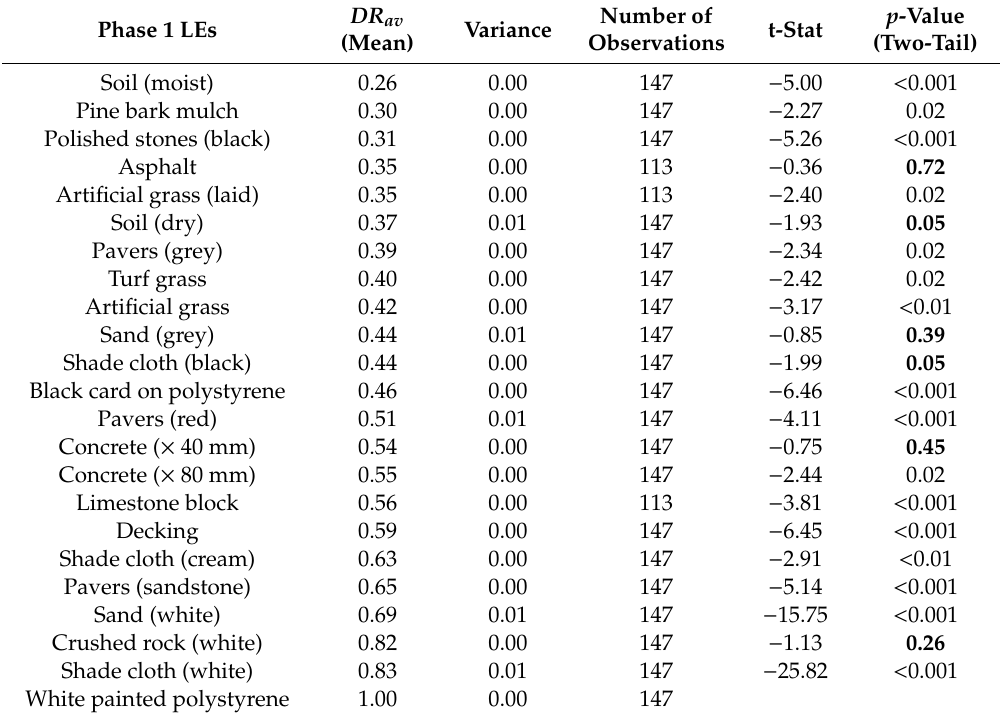
Table 5. Phase 1 seasonal DR data two sample t-test (assuming equal variances, α = 0.05). Results are a comparison of each landscape element (LE) with the LE in the row beneath it in the table. The bold p -values indicate the means of these LEs are not statistically di ff